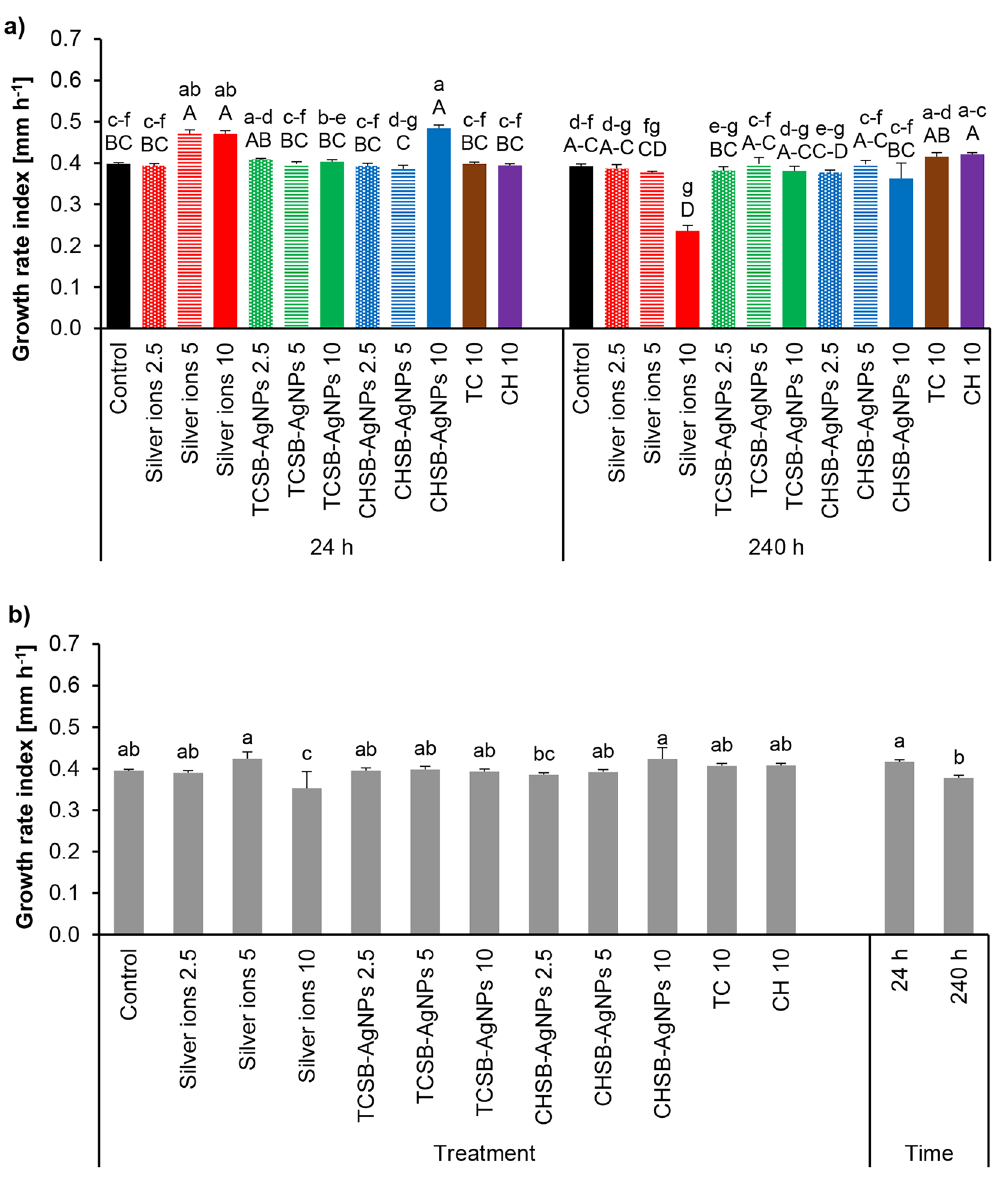
Figure 3. The impact of silver ions, AgNPs and stabilizing agents on the mycelium growth rate index of F. avenaceum after culture over 24 h and 240 h of the exposure period: factors interaction effect (a), factors effect (b). Data represents mean values ± SE. Values marked with the same letters (lowercase letters for the interaction effect, as well as the main effects of time and treatment; capital letters for interaction effect separately for the hours) are not significantly different at p ≤ 0.05. The number given for each treatment represents the concentration expressed in mg L −1